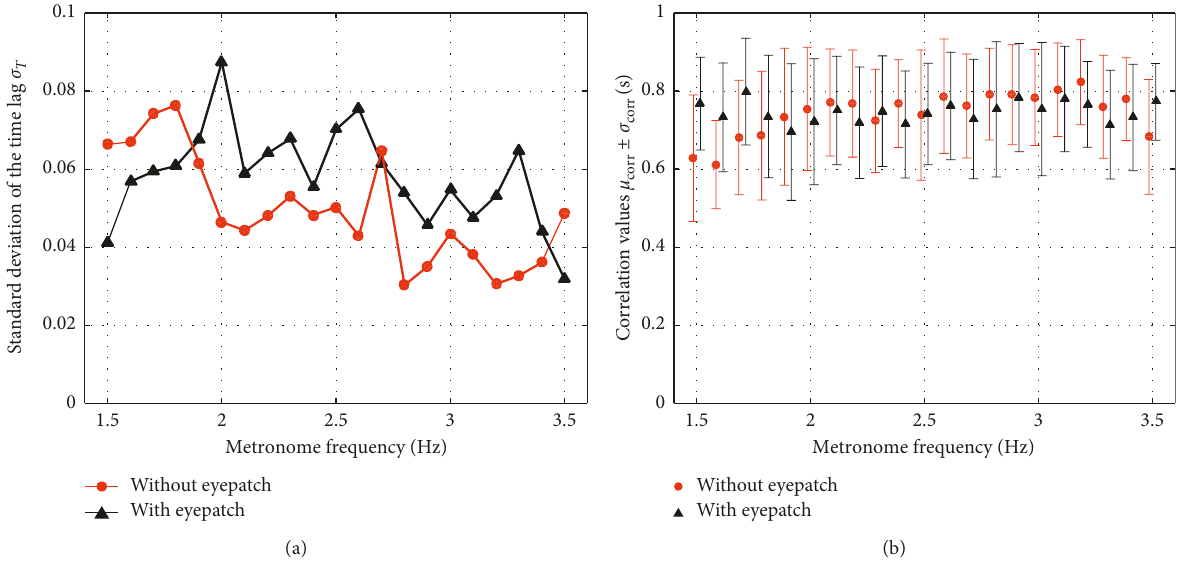
Figure 35: Comparison of the time lags (a) and correlation values (b) for visual stimuli, with and without an eyepatch.